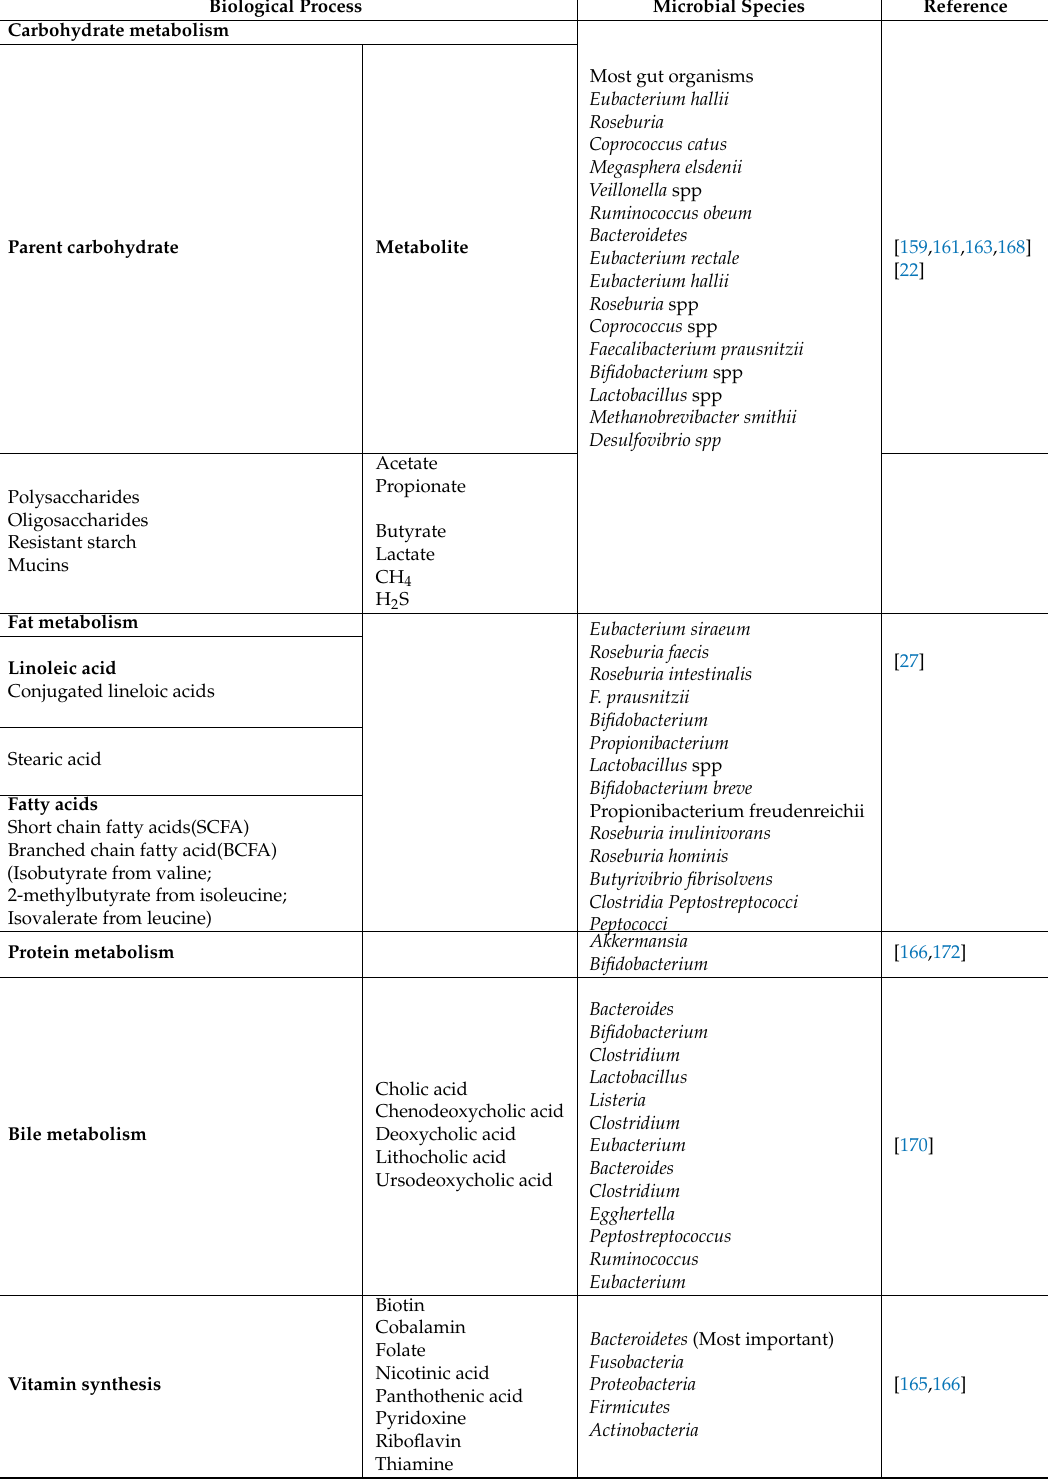
Table 1. Microbes produce various metabolites that influence multiple biological